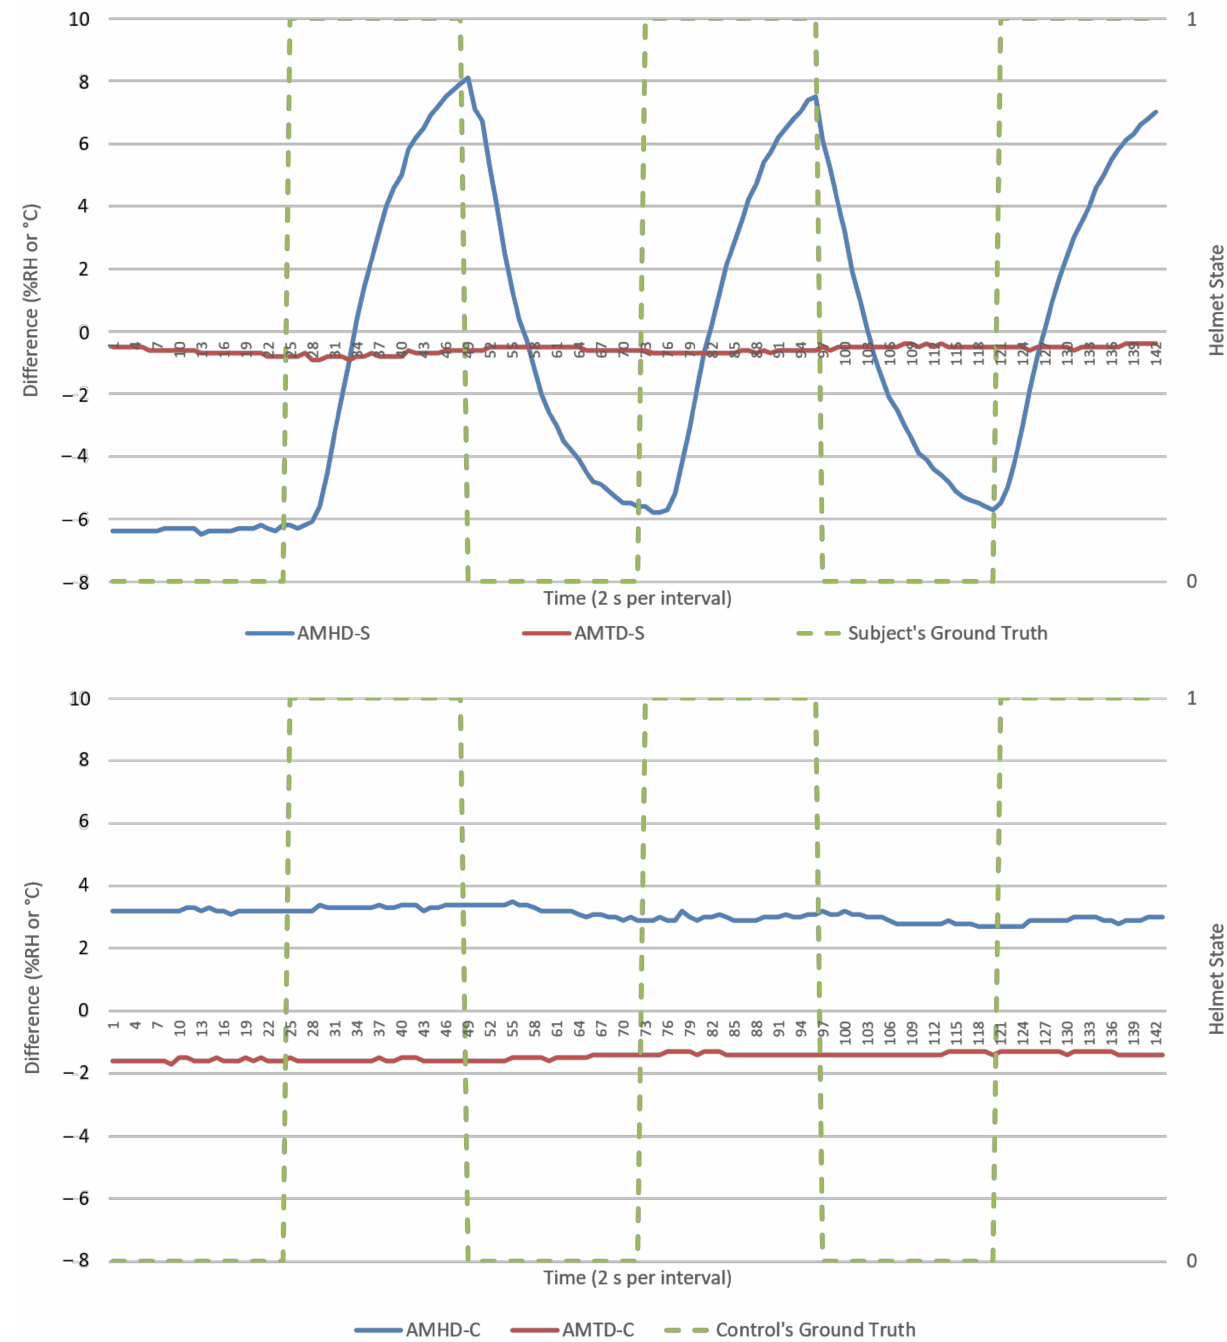
Figure 9. Ambient-microclimate differences (AMDs) versus time (2 s per interval) from a typical NM run, human subject ( top ), and experiment control ( bottom ). Helmet state 0 = NW and 1 =